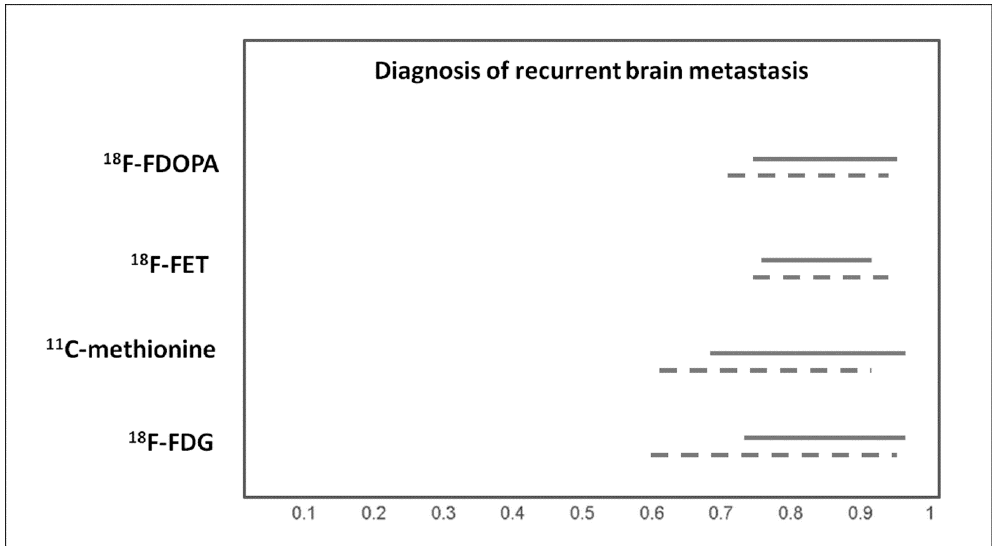
Figure 5. Graph showing 95% confidence intervals of sensitivity (continuous line) and specificity (dashed line) of PET with different tracers for diagnosis of recurrent brain metastasis, according to published meta-analyses.